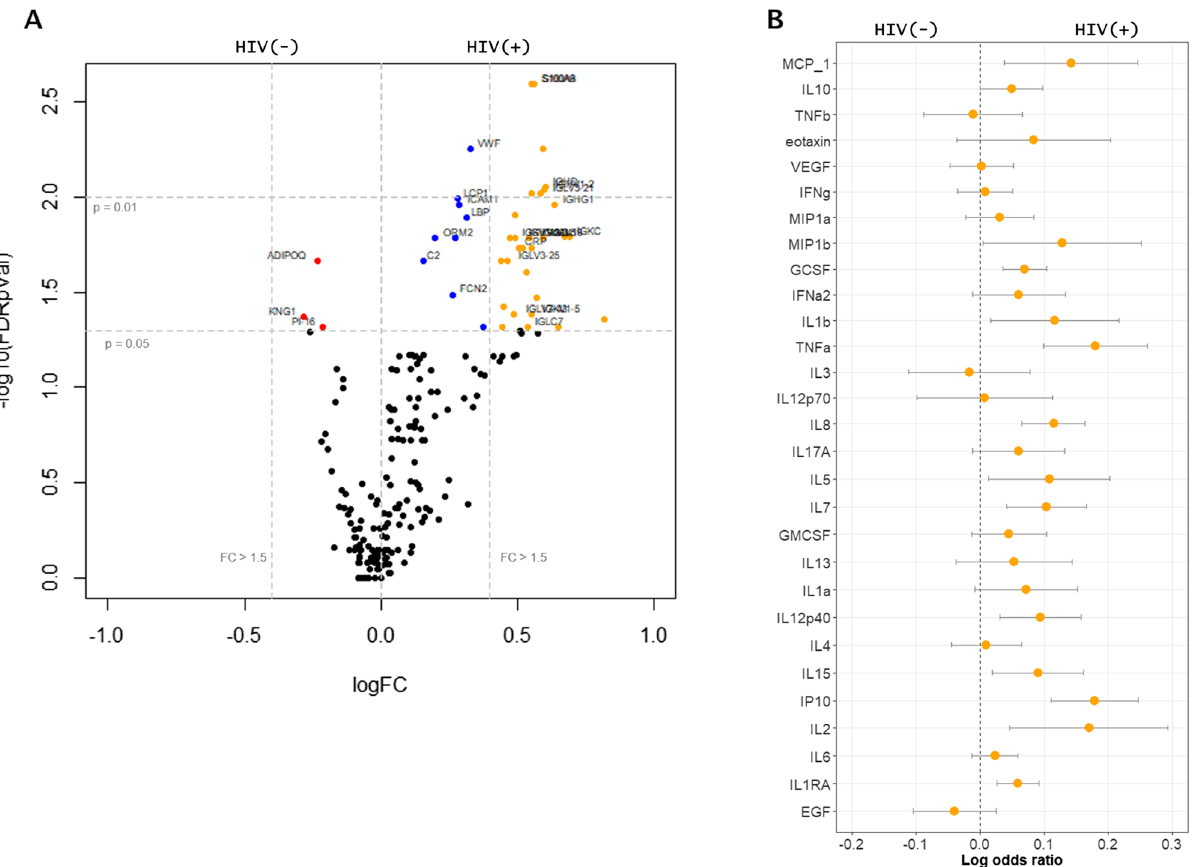
Figure 1. Univariate analysis of plasma proteome and individual plasma cytokines associated with HIV. ( A ) Volcano plot showing several significantly different (FDR adjusted p value < 0.05) proteins and their log2 HIV(+) versus HIV(−) fold change. Red points represent those significantly higher in plasma of HIV(−), blue points significantly enriched in plasma of HIV(+) and orange points significantly higher than 1.5 folds in HIV(+) compared to HIV(−) SAM children. Vertical lines indicate significance level at p = 0.05 and 0.01; horizontal lines indicate more than 1.5 folds enrichment. ( B ) Log odds plots showing association of chemokine markers analysed using Luminex platform and HIV status. Points indicate log odds ratio for every log increase in plasma protein concentration; bars indicate 95% confidence